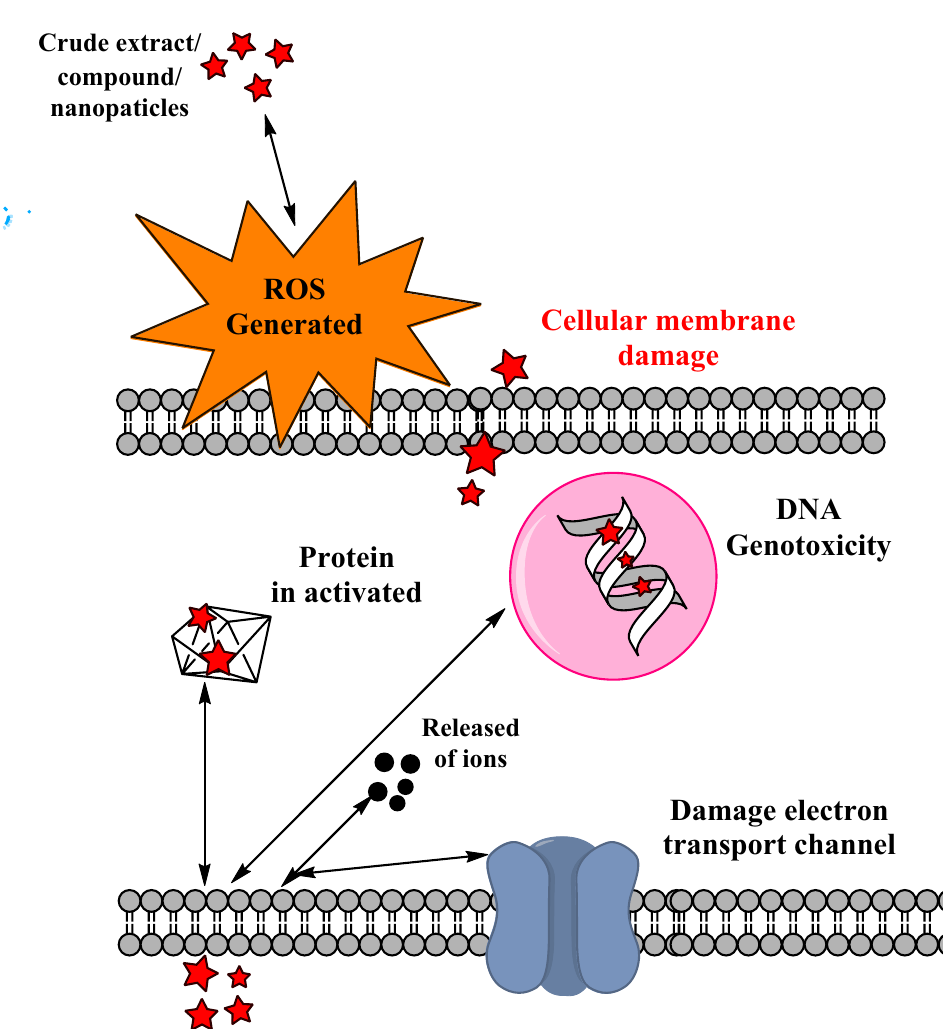
Fig. 4 Mechanism of action of C. procera part nanoparticles on